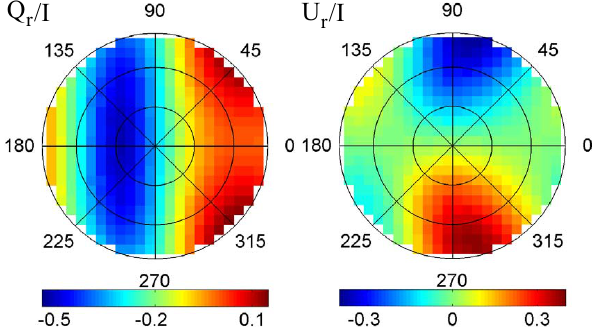
Fig. 3. Rotated relative Stokes maps Q r / I and U r / I from model cal- culations for 650nm, SZA = 60 ◦ and urban aerosol type a (Green- belt, USA) with AOD = 0.23.